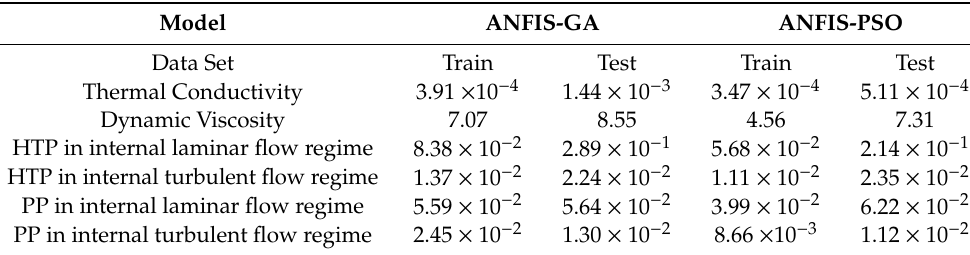
Table 3. The values of the root mean square of error (RMSE) computed for the models.